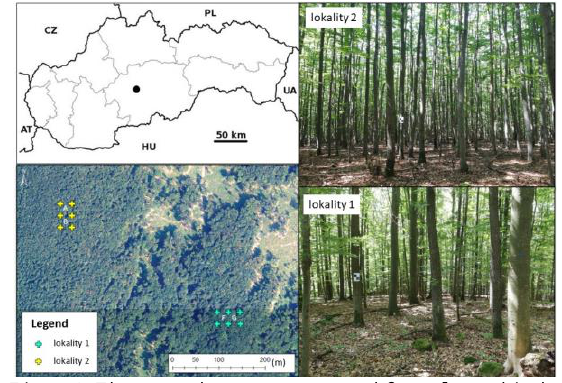
Figure 1. The research areas - a managed forest located in the Central